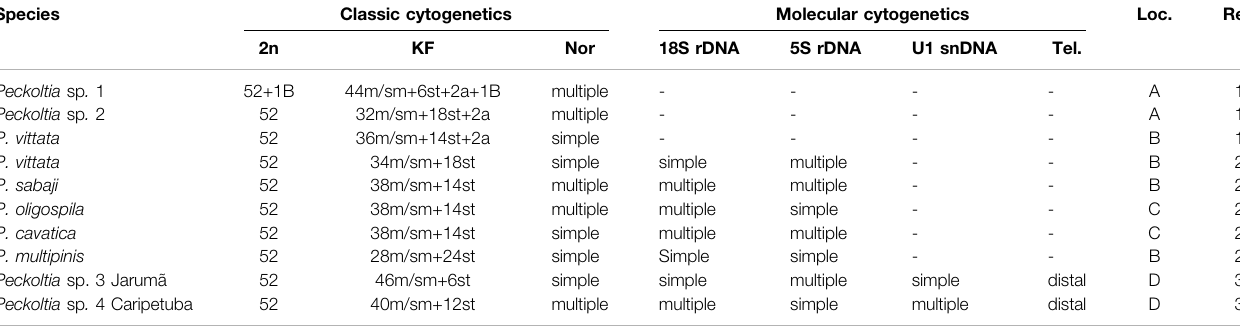
TABLE 1 | Chromosomal diversity available in the literature and obtained in the present study for Peckoltia genus. Species Classic cytogenetics